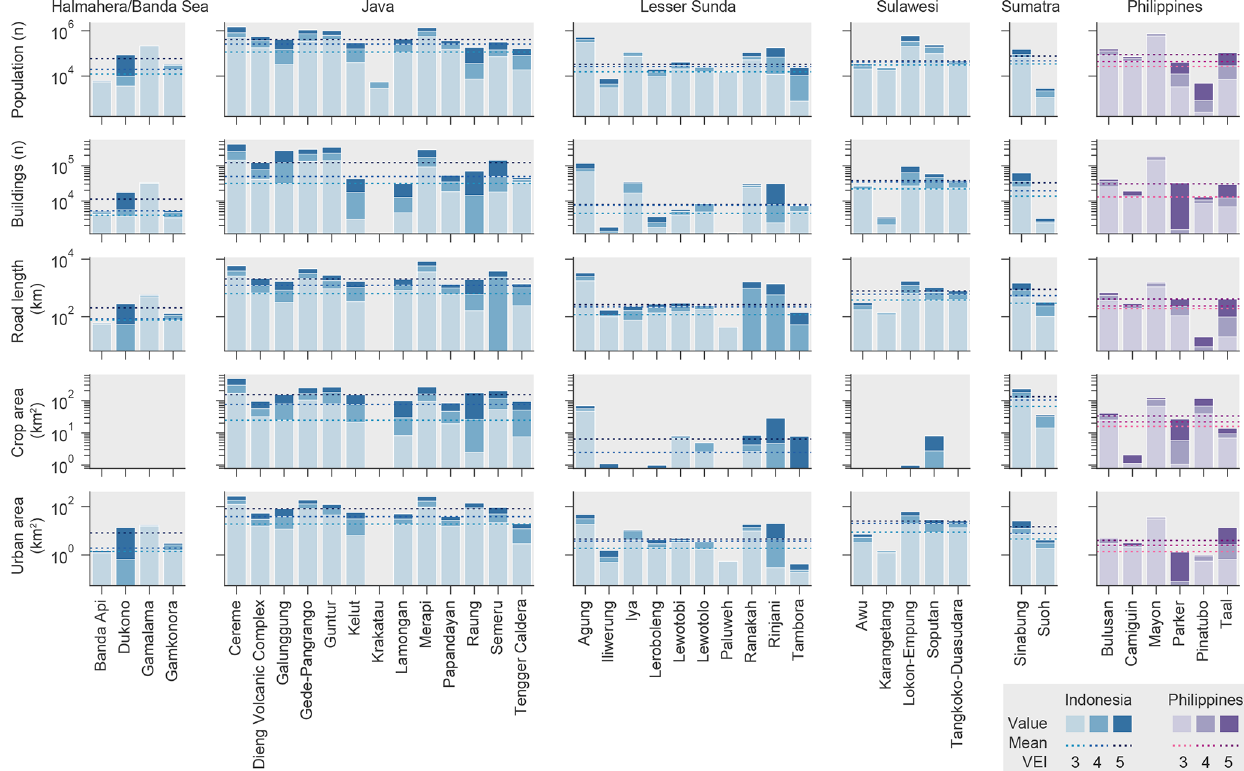
Figure 9. Exposure to inundation from column collapse PDCs summarised per region and exposure type for a conditional exceedance probability of occurrence of 50%. Bars illustrate the variability in exposure with VEI and dotted lines the median for the